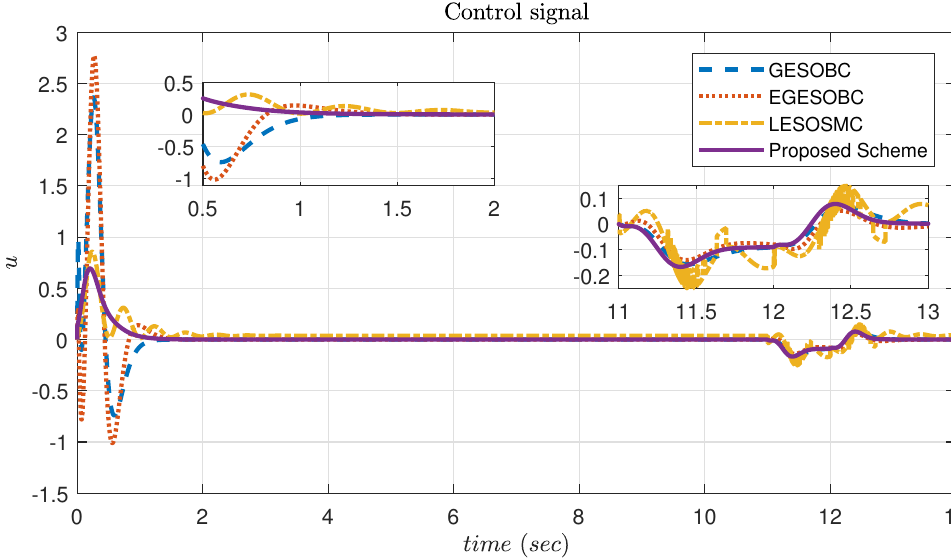
Figure 11. Simulation result of control signal for controlling θ